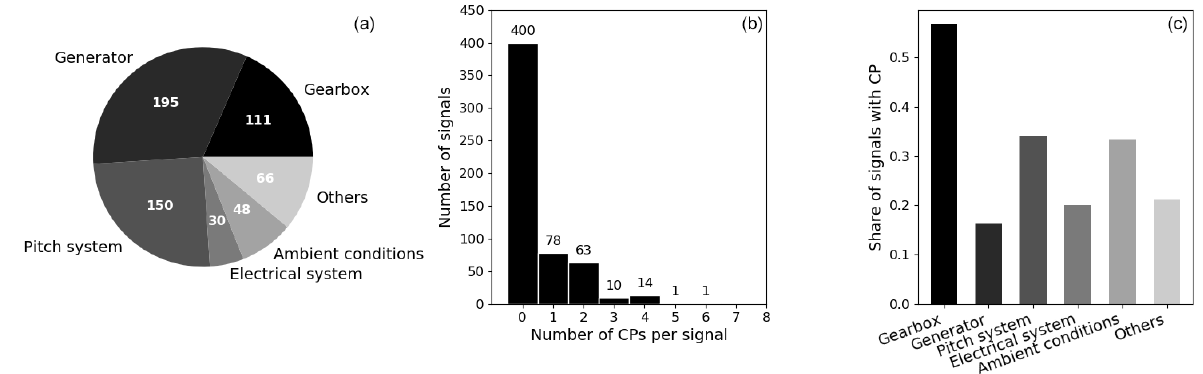
Figure 2. Number of signals per component (a) , number of CPs per signal (b) , and share of signals with CPs per component (c) for the full 2-year time